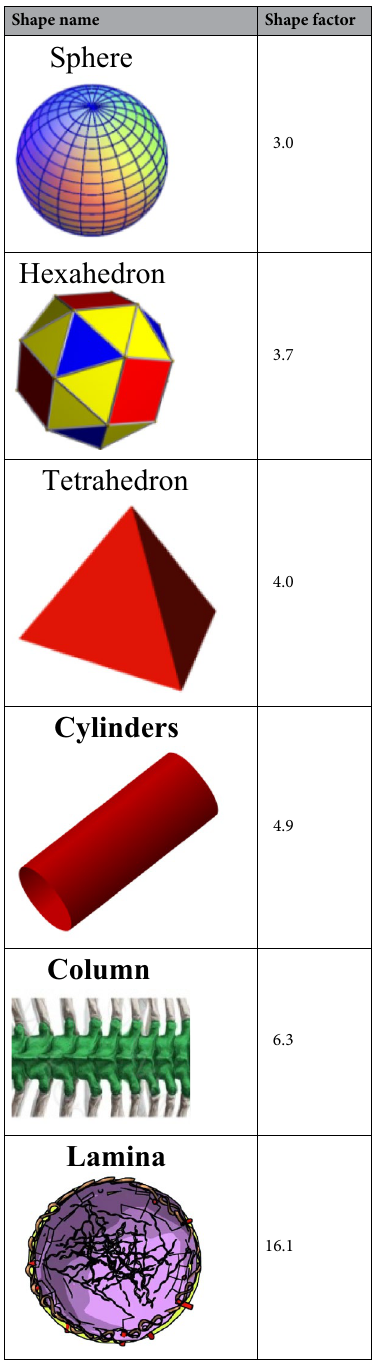
Table 4. Geometrical appearance and shape factor 46,47